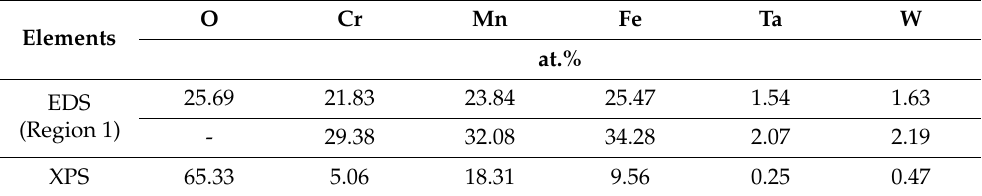
Figure 3. ( a ) The SEM surface morphology image of the ST3 sample (i.e., Cr 20 Mn 17 Fe 18 Ta 23 W 22 coating after oxidization at 800 ◦ C (6.7 ◦ C/min) for 4 h (Ar:O 2 = 3:1)); ( b ) The enlarged SEM surface morphology image of the region marked with black box in ( a ); ( c ) The enlarged SEM surface morphology image of the region marked with letter c and black box in ( b ). Table 1. Content of each element of Region 1 in Figure 3 by EDS and XPS results for the HT3 sample surface.